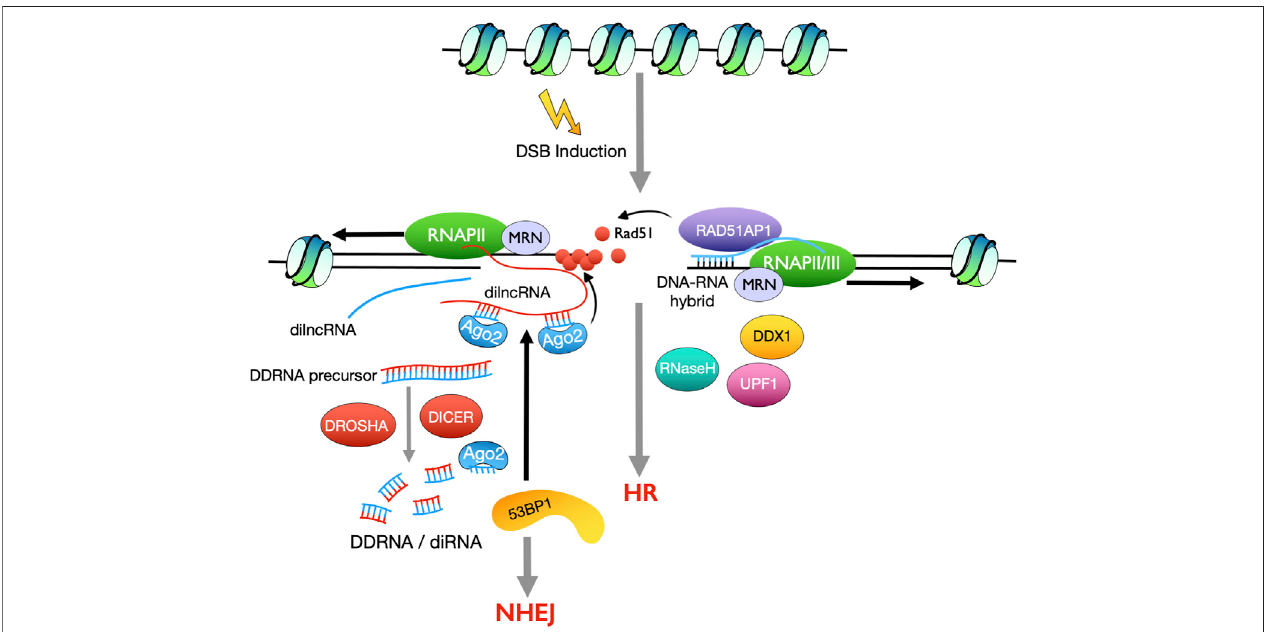
FIGURE 3 | Summary of how non-coding RNAs induced by DSBs, promote DSB repair by NHEJ and HR. Small non-coding RNAs (diRNAs/DDRNAs) and long non-coding RNAs (dilncRNAs) generated from the vicinity of DSB sites promote 53BP1 recruitment and thus NHEJ repair (left). RNA-DNAhybrids, produced byRNAPII or RNAPIII around DSBs, promote DSB repair by